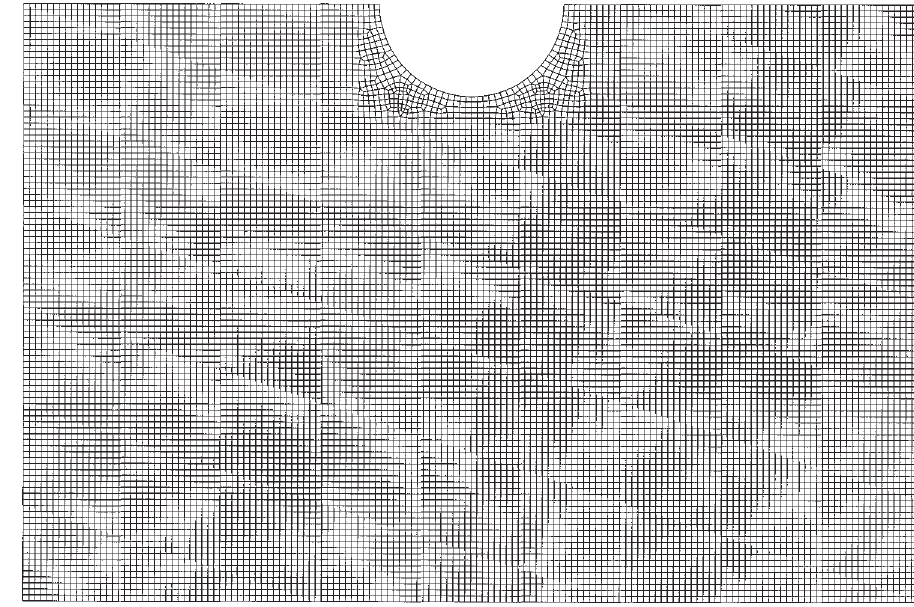
Fig. 1. Finite element model of fluid domain.